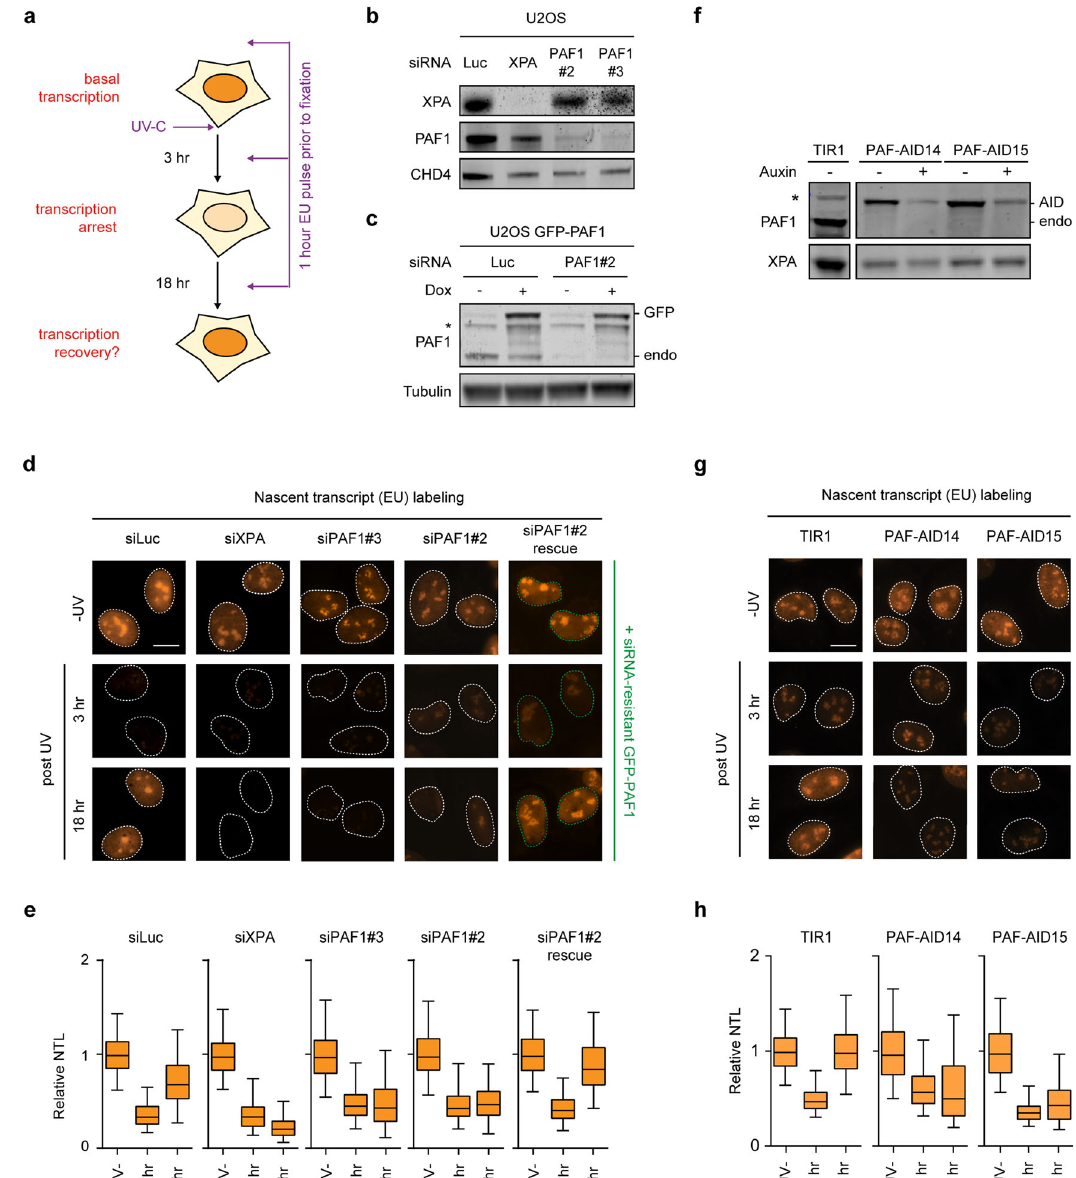
Fig. 4 PAF1C loss impairs transcription recovery after UV irradiation. a Experimental outline of the nascent transcription analyses. b Validation of the knockdown of XPA and PAF1 in U2OS cells by western blot analysis. c Validation of the knockdown of endogenous PAF1 in U2OS cells ectopically expressing siRNA-resistant PAF1 by western blot analysis. d Representative images of U2OS cells transfected with the indicated siRNAs after pulse- labeling with 5-ethynyl-uridine (5-EU). Cells with green outlines express GFP-tagged siRNA-resistant PAF1. Scale bar indicates 10 µ m. e Quanti fi cation of nascent transcript levels (NTL) from d . Boxplots represent the median, 5th and 95th percentile of all cells of three independent experiments. f Validation of auxin-induced degradation of endogenous PAF1 in two independent U2OS PAF1-AID knockin clones. g Representative images of auxin-treated U2OS TIR1 control or two PAF1-AID clones after pulse-labeling with 5-ethynyl-uridine (5-EU). Scale bar indicates 10 µ m. h Quanti fi cation of nascent transcript levels from g . Boxplots represent the median, 5th and 95th percentile of all cells of four independent experiments. b, c, f Representative fi gure of at least two